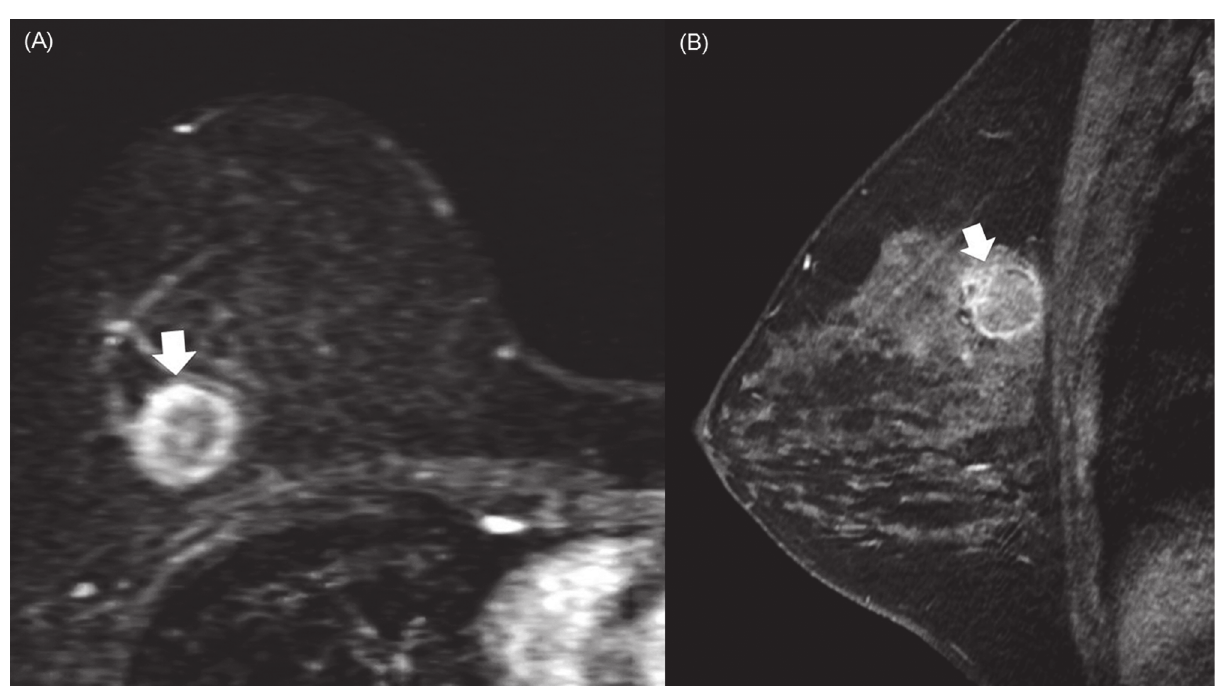
Figure 2. A triple-negative breast cancer in the posterior location. A triple-negative breast cancer in the posterior location of the right breast in a 41-year- old woman. (A) Sagittal early contrast-enhanced nonsubtracted T1-weighted MR image with fat suppression shows a 1.5 cm round mass (arrow) with rim